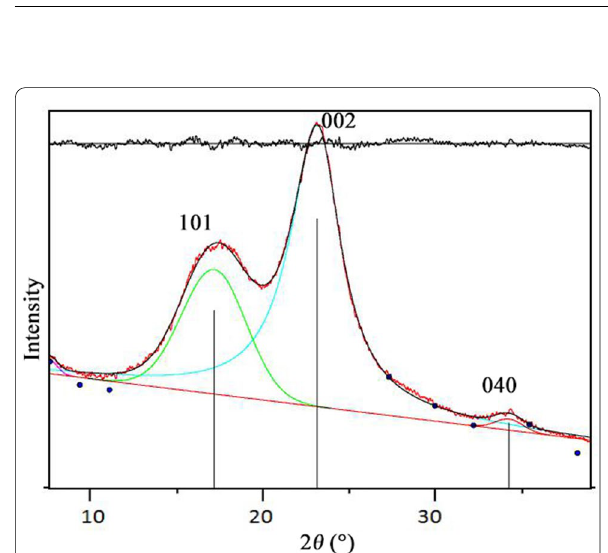
Fig. 4 The peak fitting diagram of X‑ray diffraction results